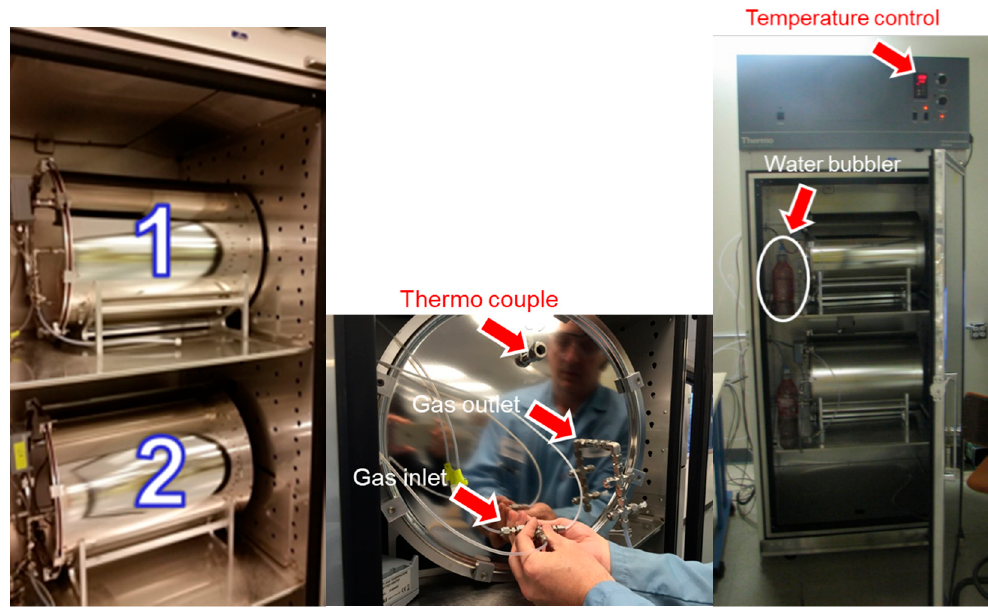
Figure 2. Set up for the validation in the chamber.